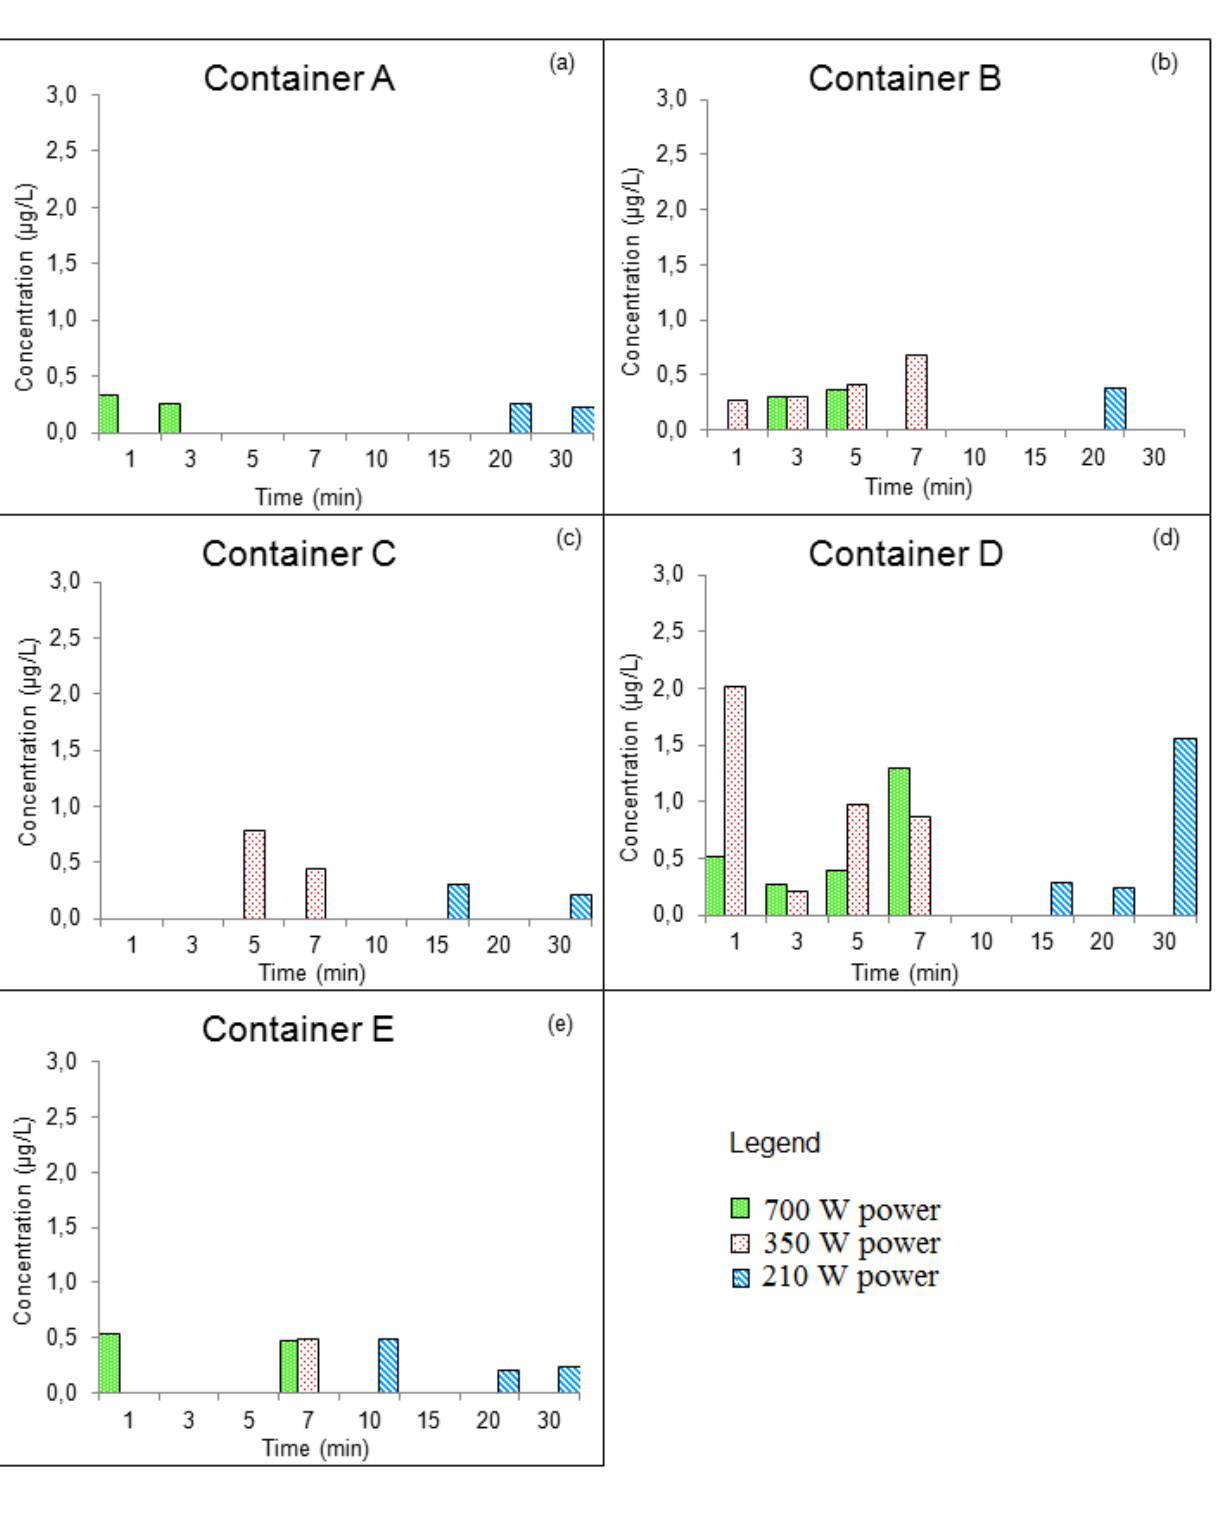
Figure 3. Concentrations of DBP that migrated into Group I food simulant ( a ) container